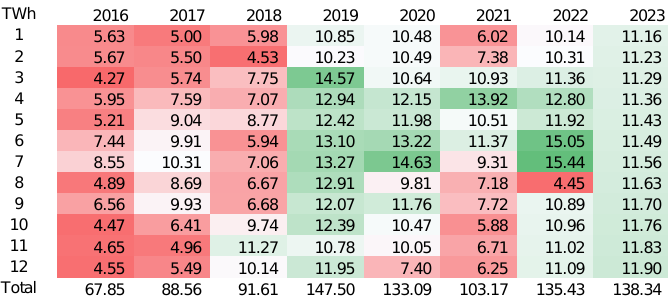
Figure 9. Neutral forecast of LNG for 2024. Forecast exercised for the period September 2022 to December 2023. These data can be found here: https://www.ec.europa.eu/ (accessed on 20 March 2022).